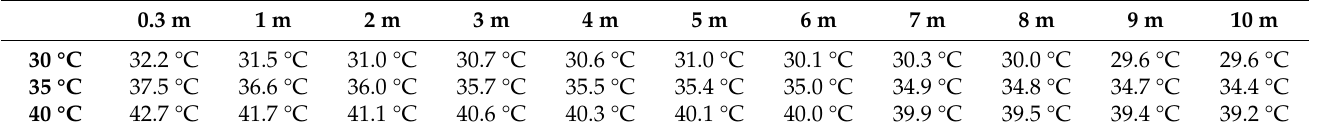
Table 5. The temperature estimation result from FLIR Tools + (FLIR correction).